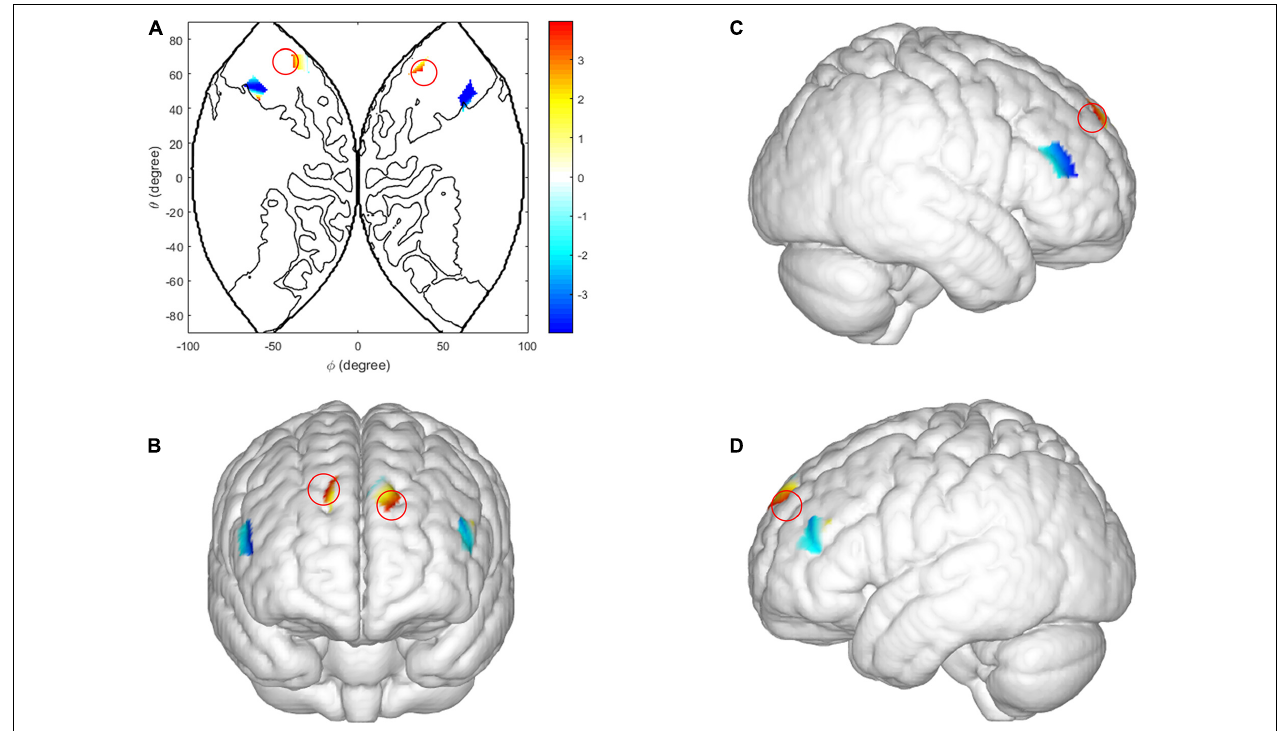
FIGURE 4 | Intra-brain activation in the TCDM stage. (A–D) Higher activations in the DLPFC and the middle frontopolar area (LIR condition vs. HIR condition). (A) The 2D model of activation map of the DLPFC and the middle frontopolar area; (B) front, (C) right, and (D) left view of a 3D model of activation map of the DLPFC and the middle frontopolar